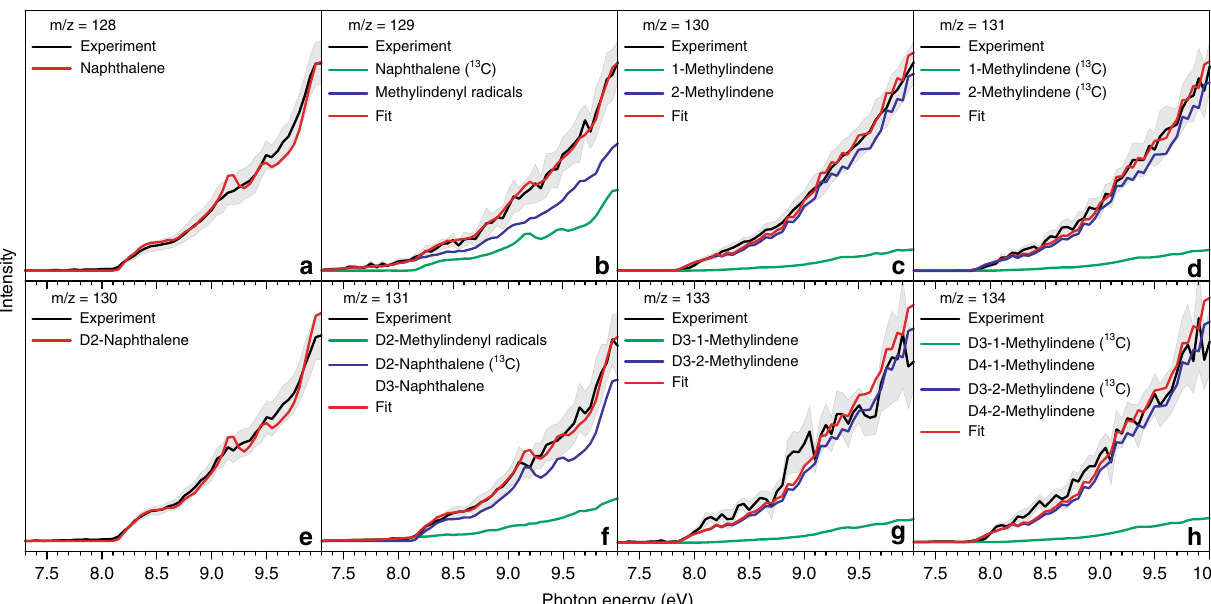
Fig. 3 PIE curves for different products. a – d PIE curves for the reaction of 1-indenyl with methyl and e – h PIE curves for the reaction of 1-indenyl with D3- methyl at a reactor temperature of 1425 ± 10 K. Black: experimental PIE curves; blue/green/red: reference PIE curves; in case of multiple contributions to one PIE curve, the red line resembles the overall fi t. The error bars consist of two parts: ±10% based on the accuracy of the photodiode and a 1 σ error of the PIE curve averaged over the individual scans. Source data are provided as a Source Data fi